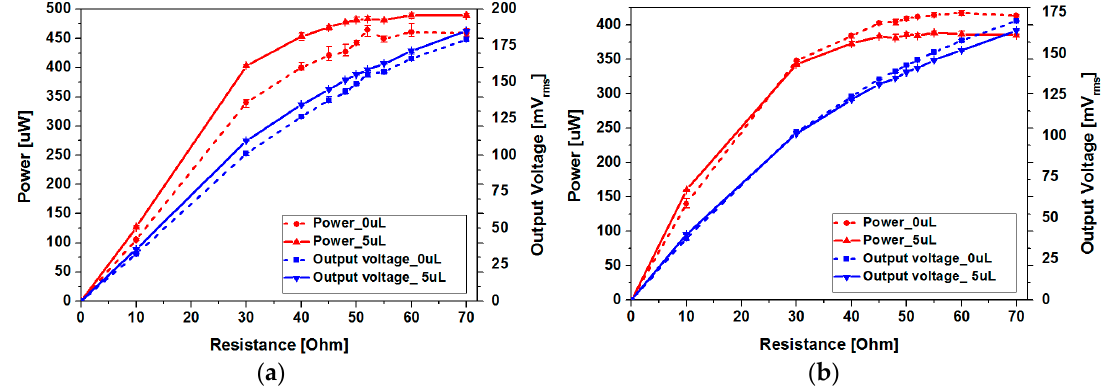
Figure 12. Output power and voltage at various load resistances for devices with different channel surface roughness: ( a ) type 1; ( b ) type 2.